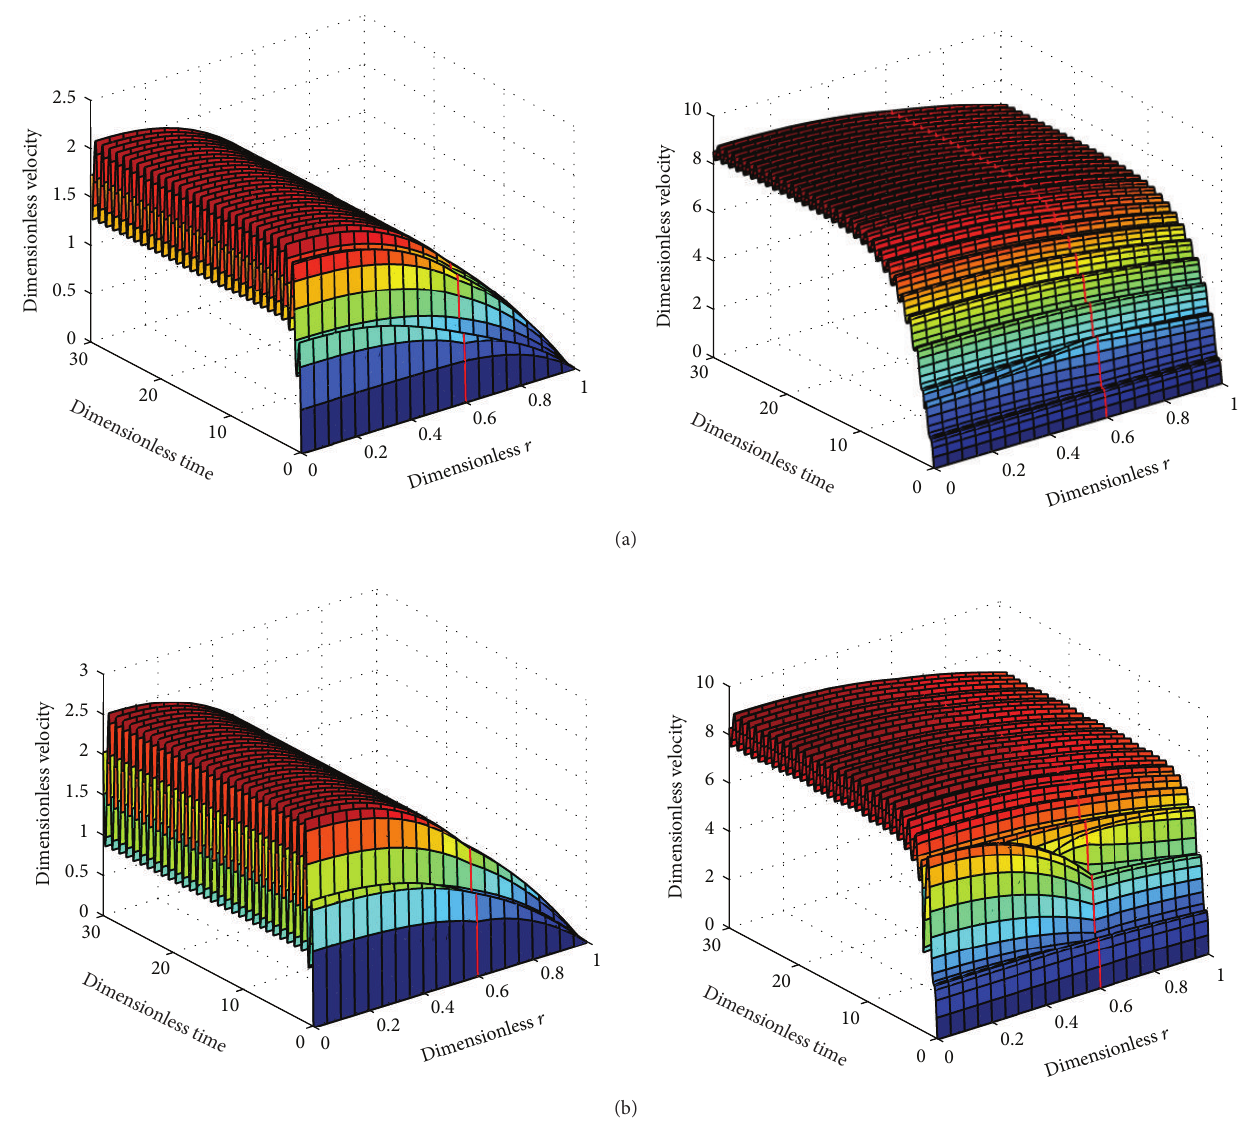
Figure 6: Velocity profiles in arteries with different slip parameters 𝑙 𝑏 and radii 𝑟 : (a) 𝑟 = 0.15 cm; (b) 𝑟 = 0.50 cm. In the Figure, the graphs on the left column correspond to 𝑙 𝑏 = 0 , while the graphs on the right column correspond to 𝑙 𝑏 = 2 .